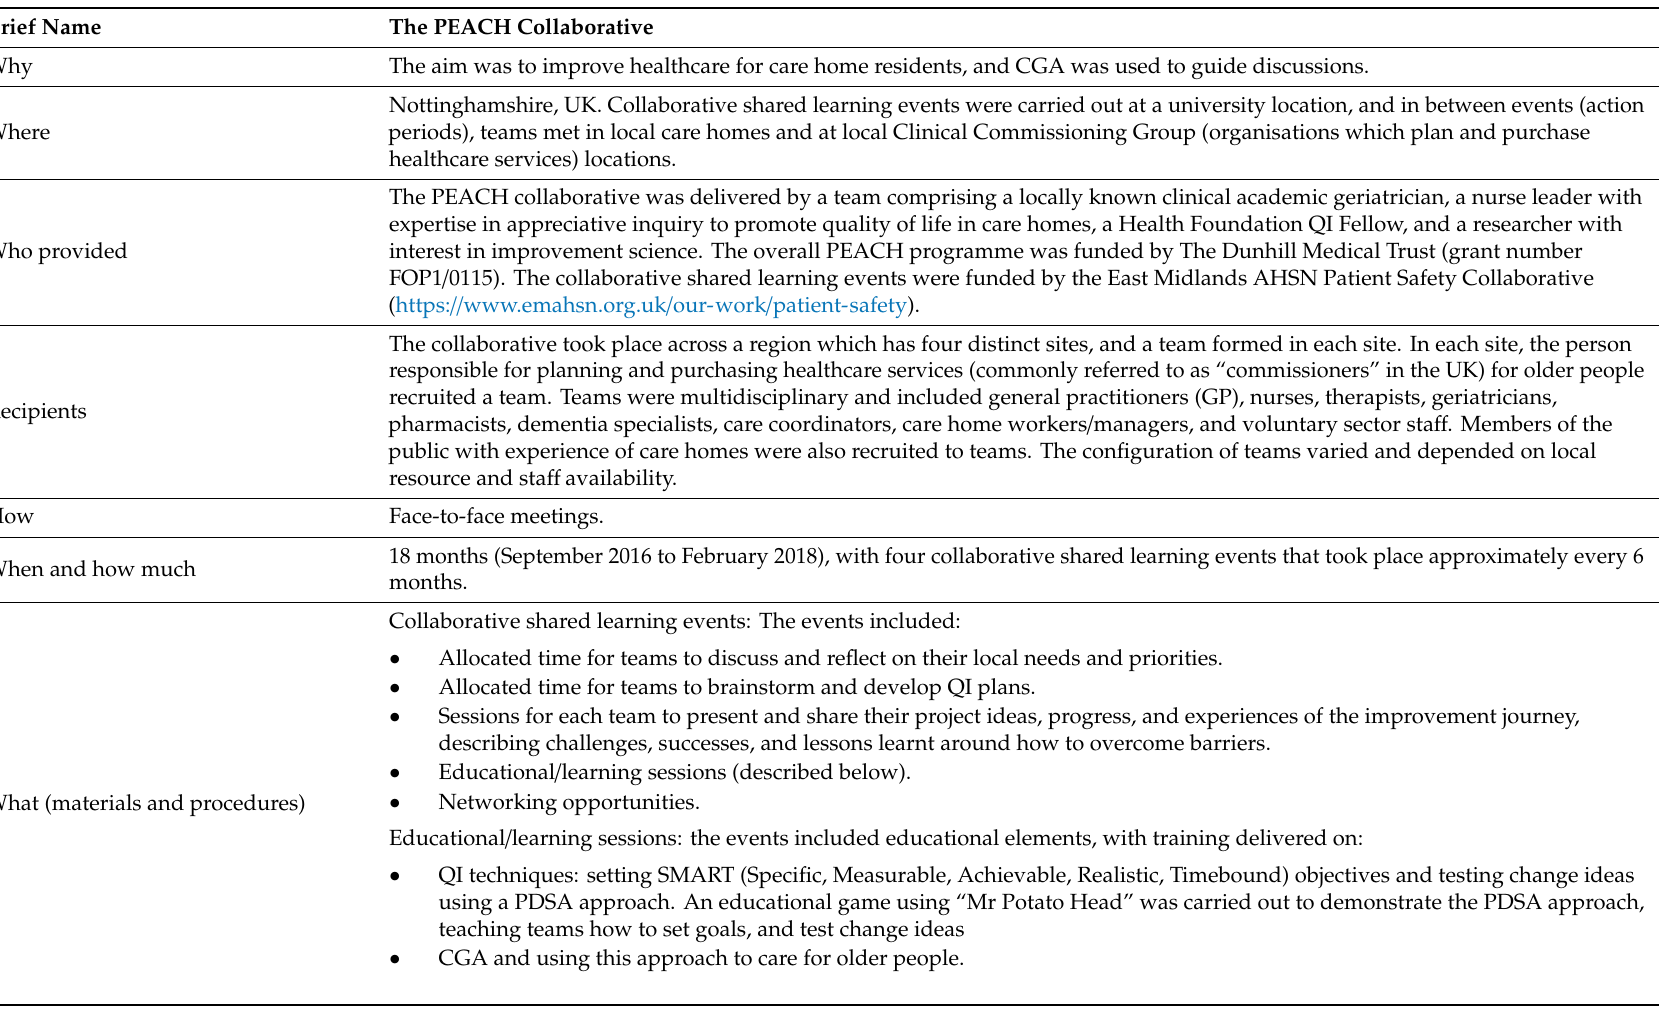
Table 1. Description of the PEACH Quality Improvement